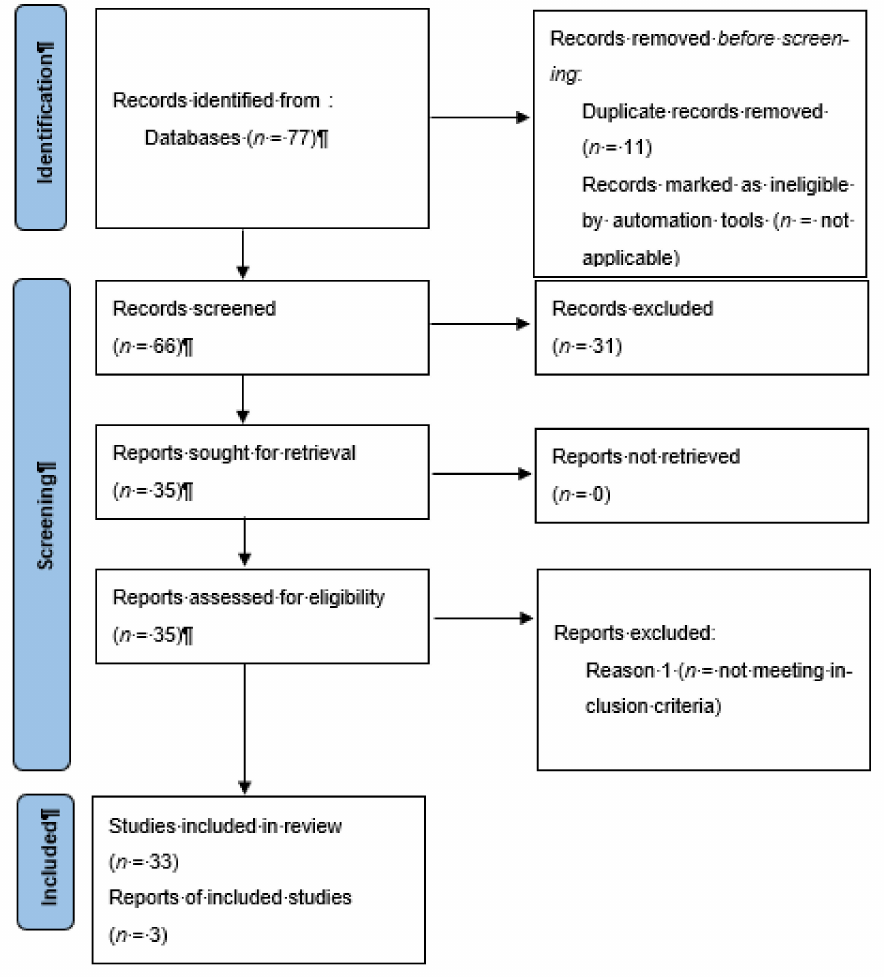
Figure 7. Literature search and article selection following PRISMA